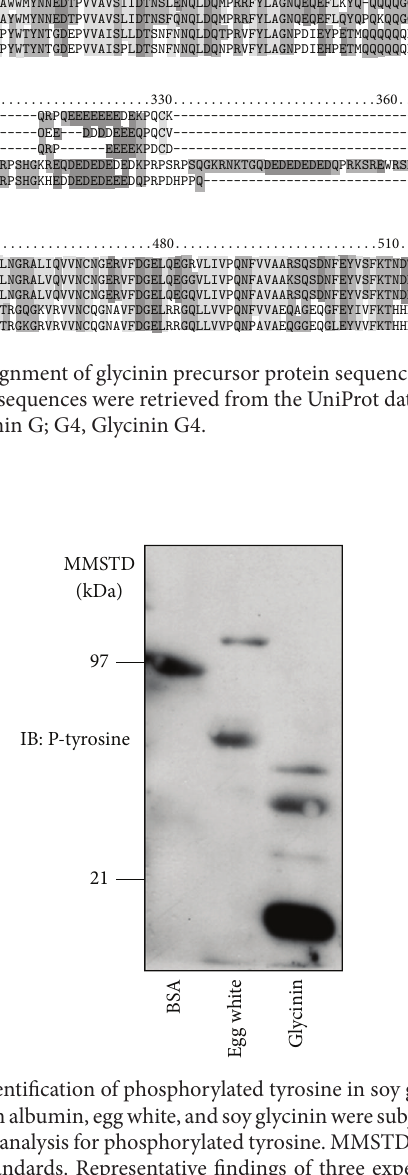
IAVPTGVAWWMYNNEDTPVVAVSIIDTNSLENQLDQMPRRFYLAGNQEQEFLKYQ--QEQGGHQS--QKGKHQQEEENEGGSILSGFTLEFLEHAFSVDKQIAKNLQGENEGEDKGAIVTVKGGLSVIKPPTDEQQ-------------- 273 IAVPTGVAWWMYNNEDTPVVAVSIIDTNSLENQLDQMPRRFYLAGNQEQEFLKYQ-QQQQGGSQS--QKGK-QQEEENEGSNILSGFAPEFLKEAFGVNMQIVRNLQGENEEEDSGAIVTVKGGLRVTAPAMRKPQ-------------- 270 IAVPTGFAYWMYNNEDTPVVAVSLIDTNSFQNQLDQMPRRFYLAGNQEQEFLQYQPQKQQGGTQS--QKGKRQQEEENEGGSILSGFAPEFLEHAFVVDRQIVRKLQGENEEEEKGAIVTVKGGLSVISPPTEEQQ-------------- 272 LVIPPSVPYWTYNTGDEPVVAISLLDTSNFNNQLDQTPRVFYLAGNPDIEYPETMQQQQQQKSHGGRKQGQHQQEEEEEGGSVLSGFSKHFLAQSFNTNEDIAEKLESPDDERKQ--IVTVEGGLSVISPKWQEQQDEDEDEDEDDEDEQ 294 LVIPLGVPYWTYNTGDEPVVAISPLDTSNFNNQLDQNPRVFYLAGNPDIEHPETMQQQQQQKSHGGRKQGQHRQQEEE-GGSVLSGFSKHFLAQSFNTNEDTAEKLRSPDDERKQ--IVTVEGGLSVISPKWQEQ--EDEDEDEDEEYGR 291